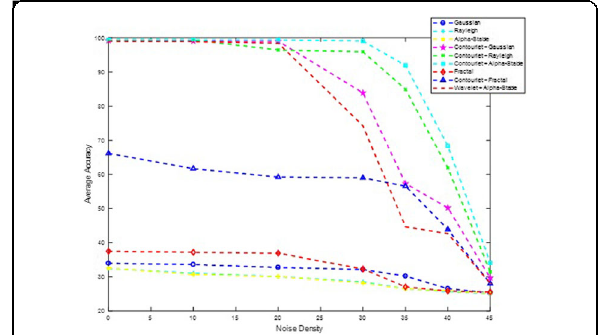
Fig. 24 Average segmentation accuracy of different methods in the presence of noise for KTH-TIPS2 mosaics